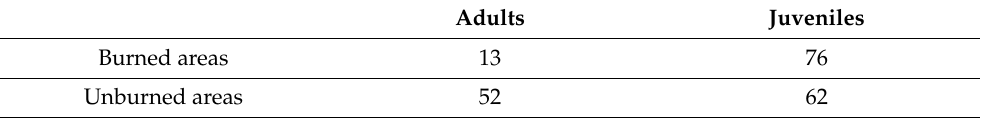
Table 2. Number of adult and juvenile green tree frogs captured in burned versus unburned areas.